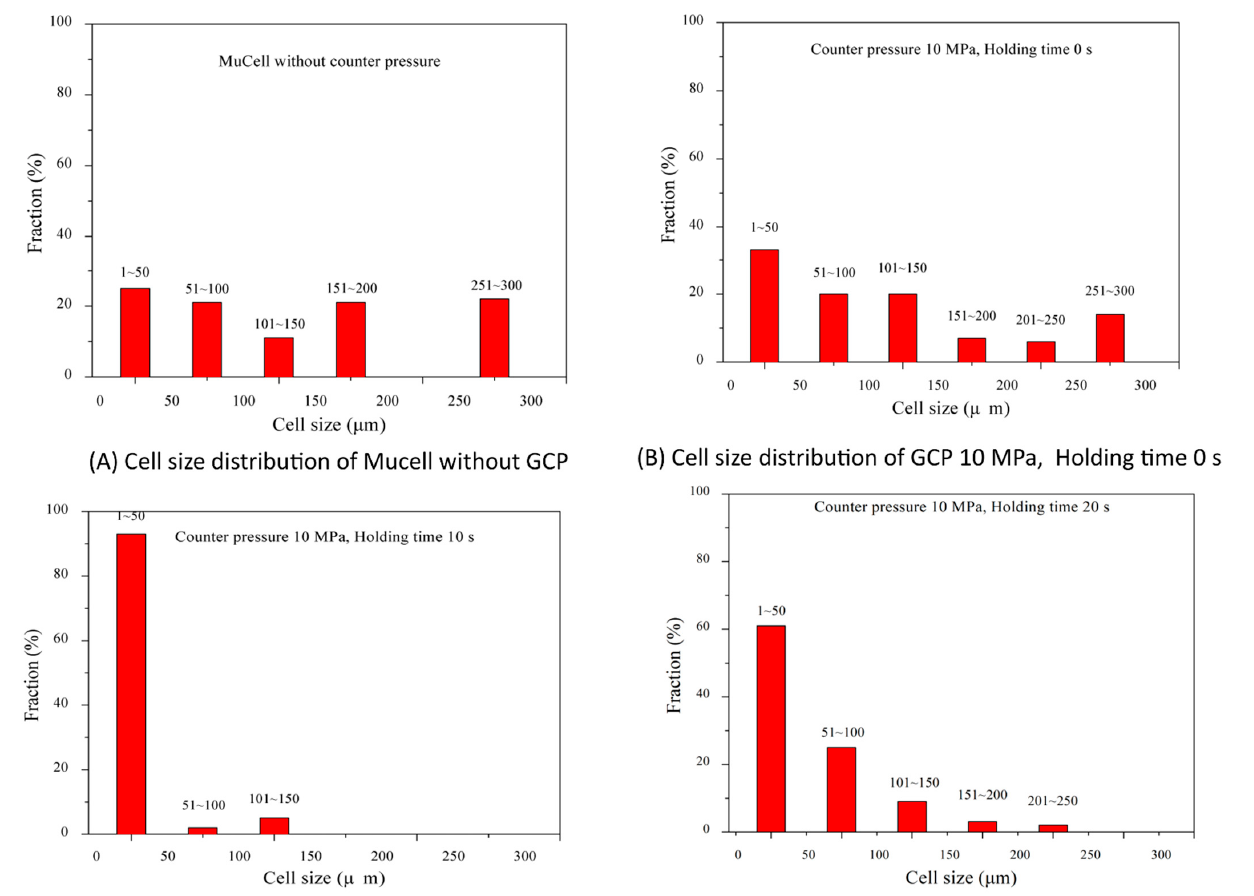
Figure 5. Cell size distribution of Figure 4. Table 2. Average cell size and skin thickness of the microcellular injection molding with GCP and different holding times.